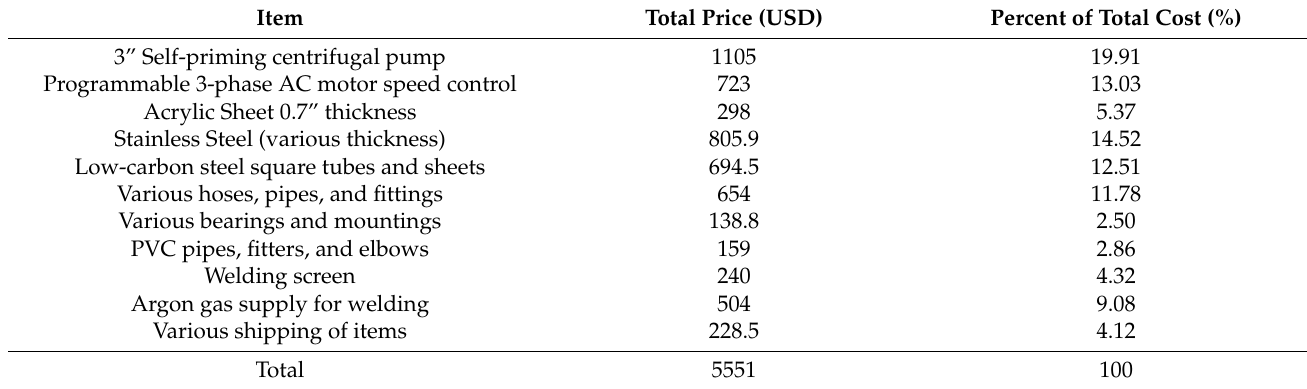
Table 9. List of major components of the flume, amount and its 2018 price. Note that the labor cost is not included here.